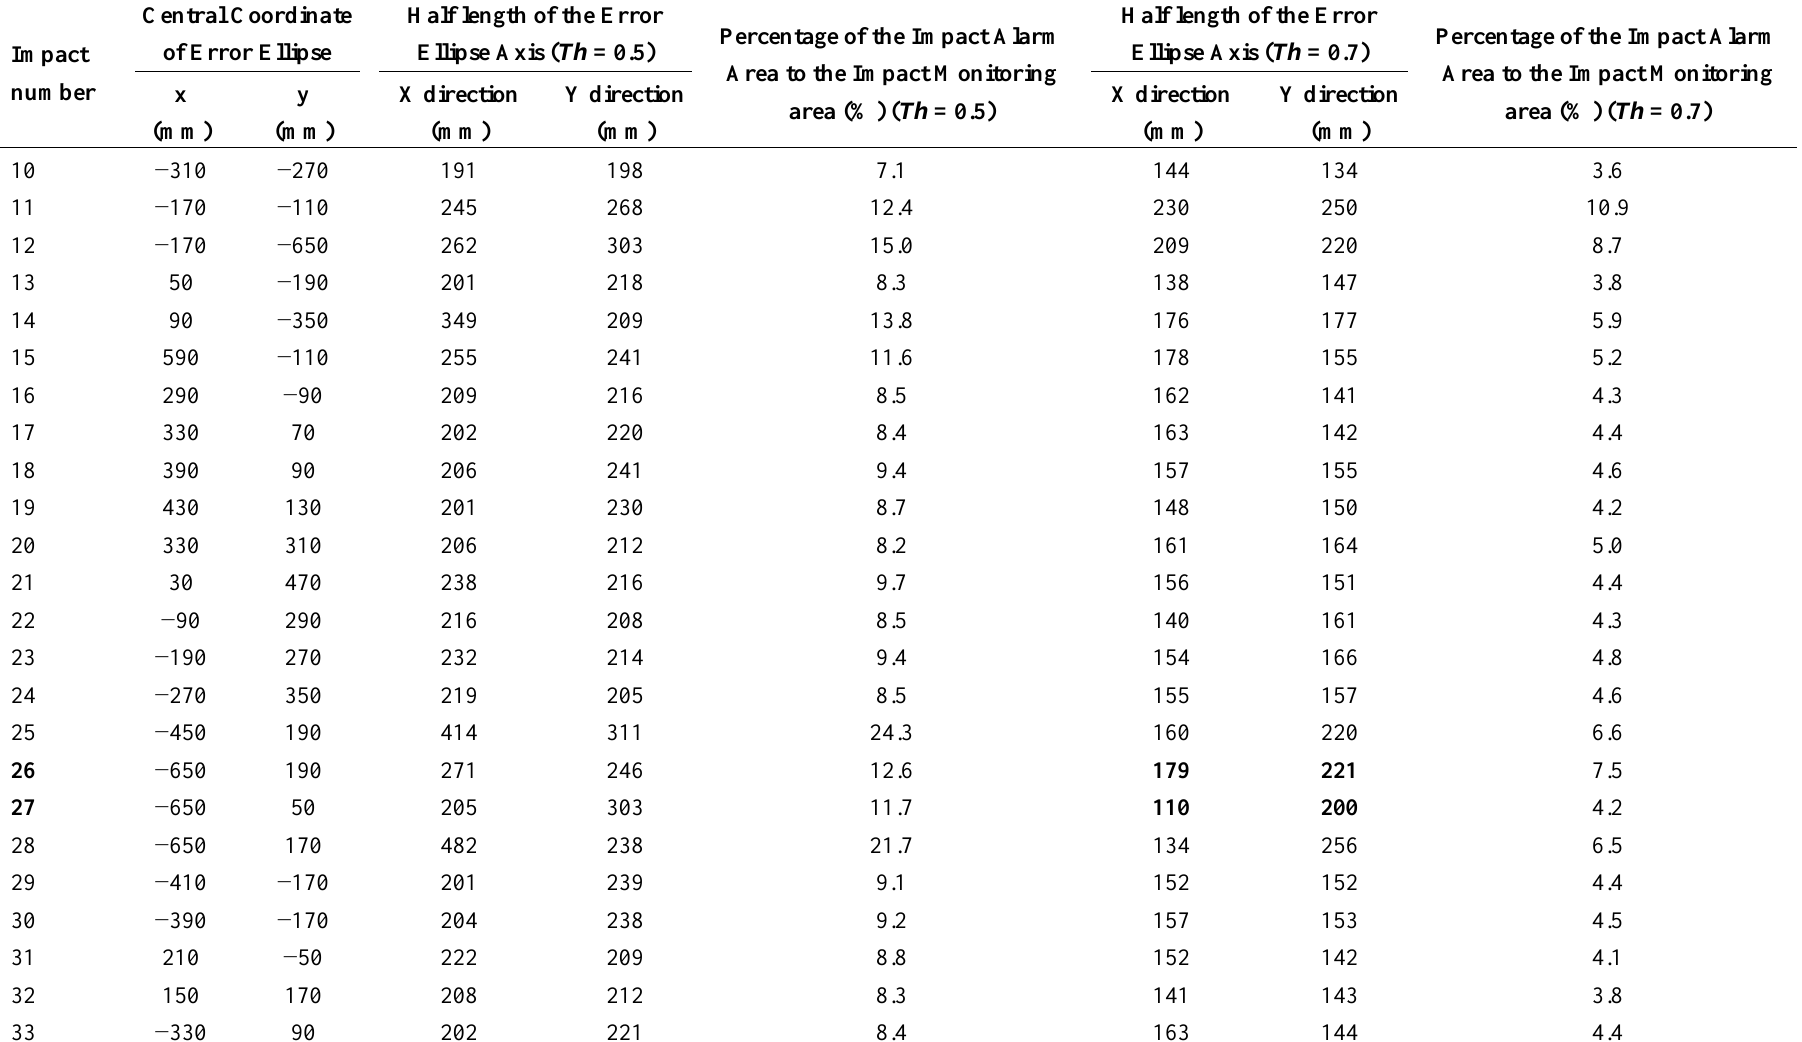
Table 3. Results of impact monitoring region 1 obtained by using impact alarm region imaging